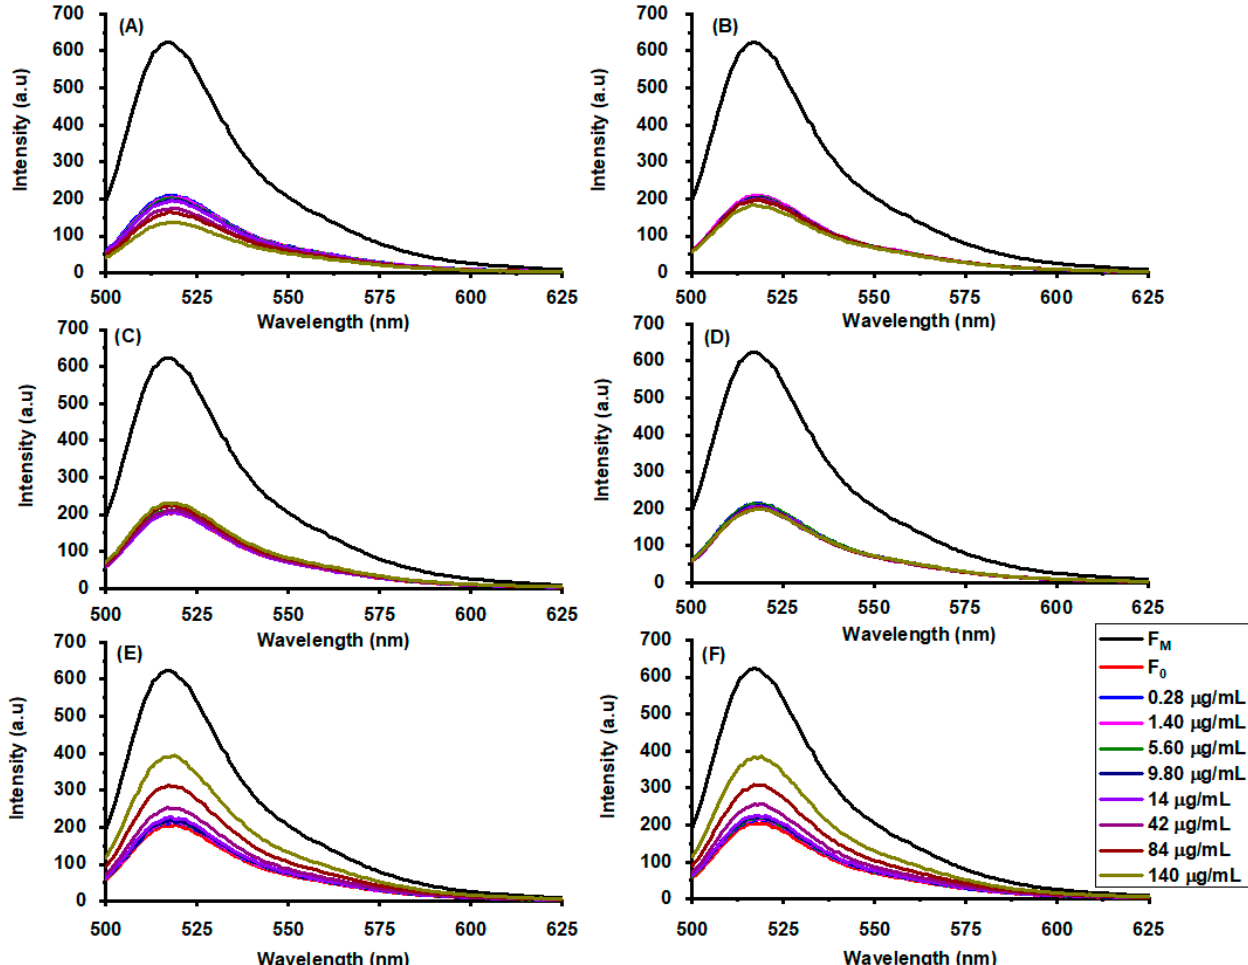
Figure 1. Leakage-induced fluorescence emission spectra of calcein, encapsulated in the GUV, after interaction with various concentrations of ( A ) curcumin-loaded succinylated pea protein, ( B ) curcumin-loaded native pea protein, ( C ) curcumin-loaded succinylated pea protein-chitosan, ( D ) curcumin-loaded native pea protein-chitosan, ( E ) hollow succinylated pea protein-chitosan, and ( F ) hollow native pea protein-chitosan complexes.